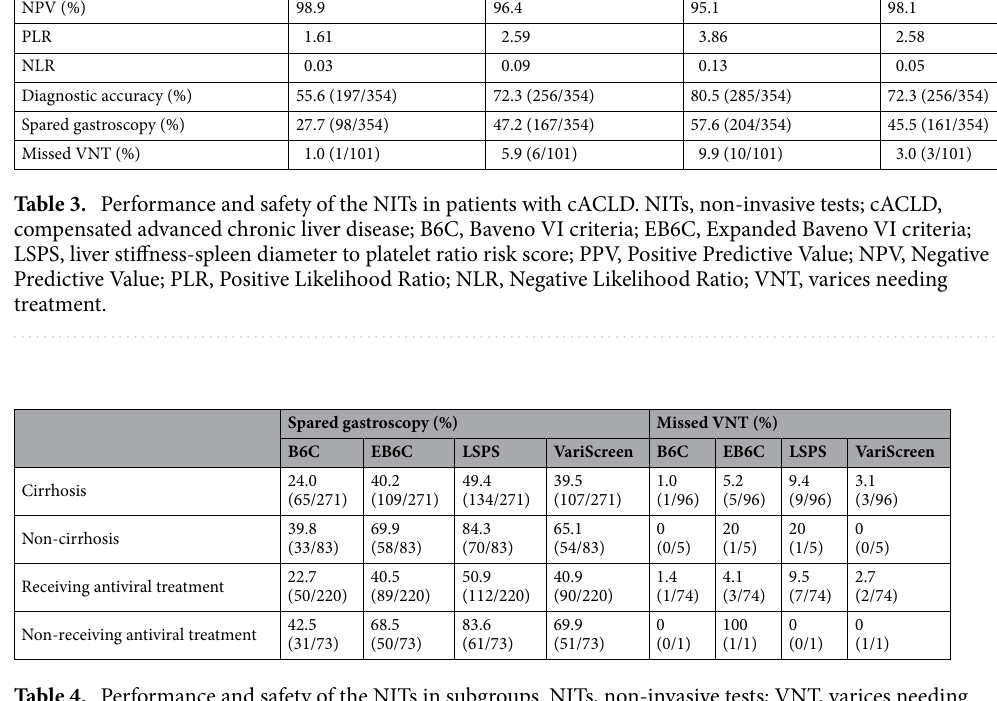
Table 4. Performance and safety of the NITs in subgroups. NITs, non-invasive tests; VNT, varices needing treatment; B6C, Baveno VI criteria; EB6C, Expanded Baveno VI criteria LSPS, liver stiffness-spleen diameter to platelet ratio risk